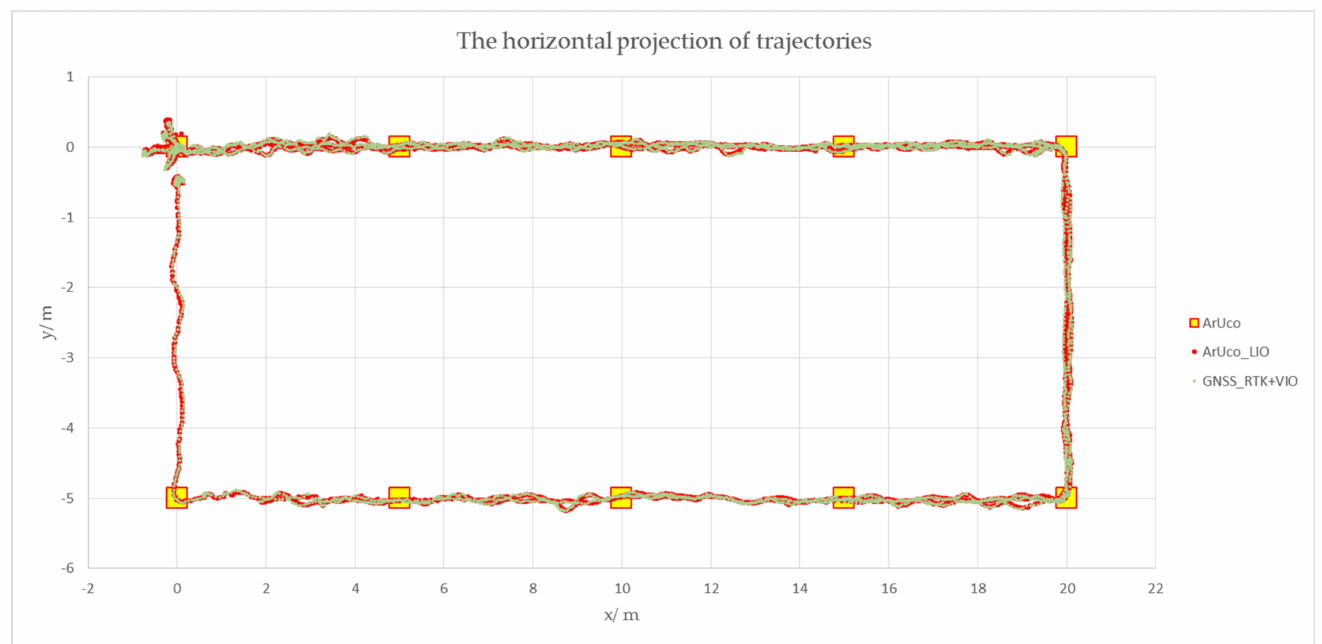
Figure 14. The horizontal projection of the track.